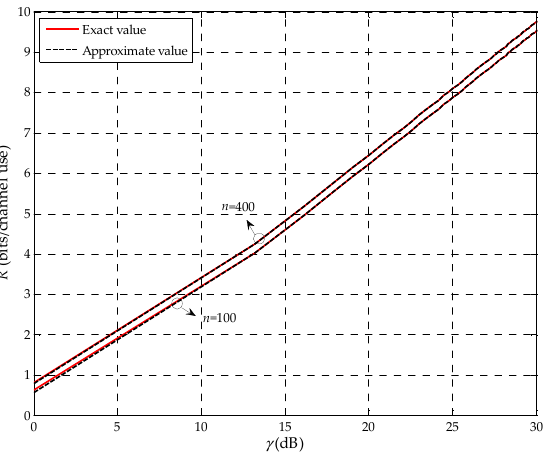
Figure A1. R with γ via Equation (1) and Equation (A2).